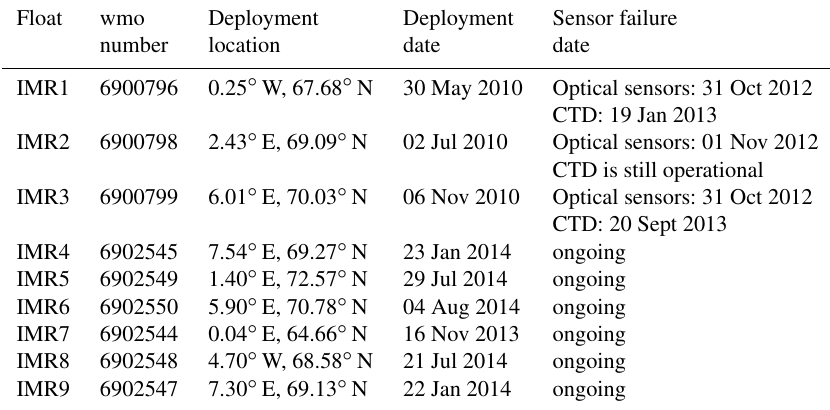
Table 1. Relevant information concerning the nine bio-optical profiling floats used in this study. Float wmo